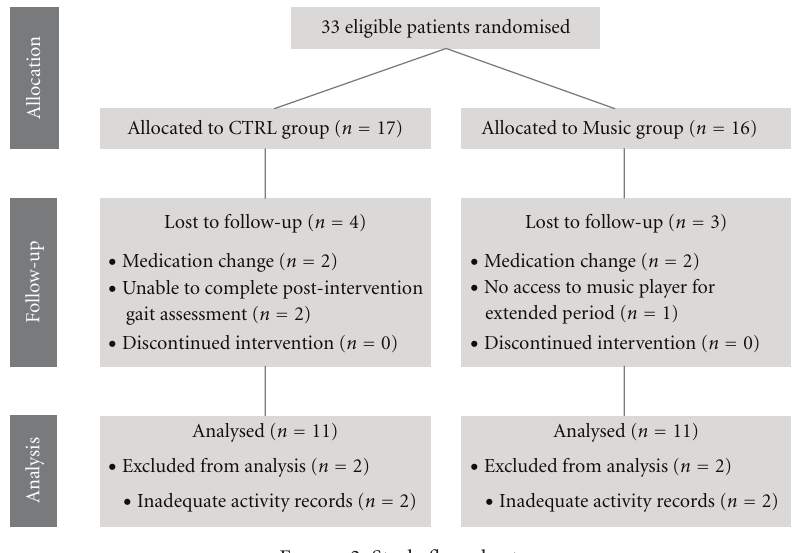
Figure 2: Study flow chart. Table 2: Summary of descriptive statistics and change scores for the CTRL group for outcome measures pre and post